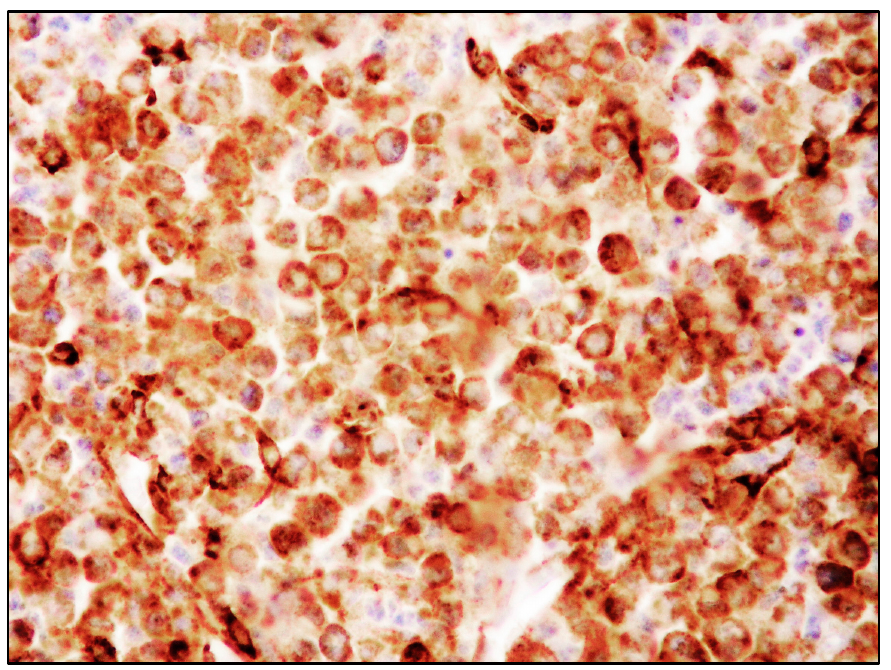
Figure 5. High-power view of BM infiltrate showing a diffuse and intense CD25 positivity (CD25 immunostaining, magnification 400×; original image from Prof. S.A.).